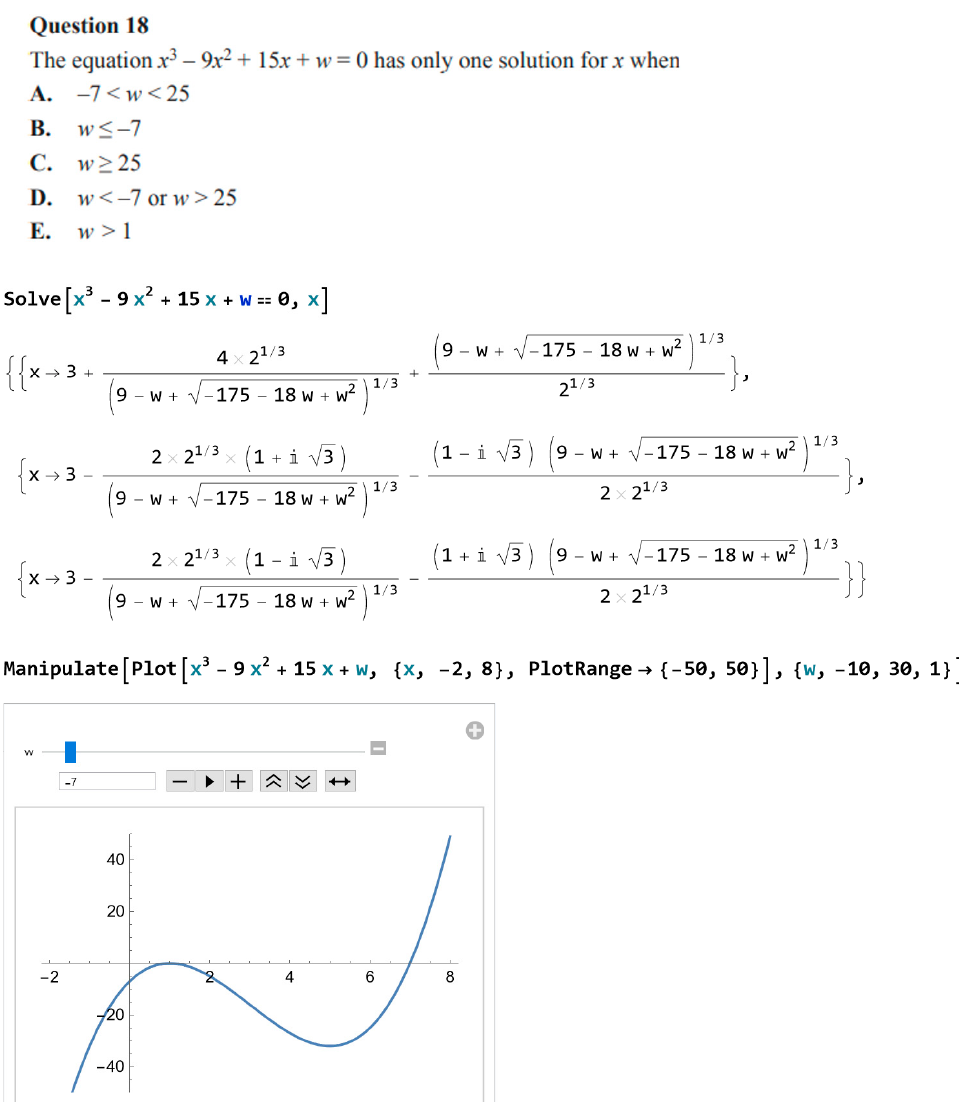
Figure 3. The 2011 Mathematical Methods Examination 2, multiple-choice Question 18 (© VCAA 2011; by permission) and computations.